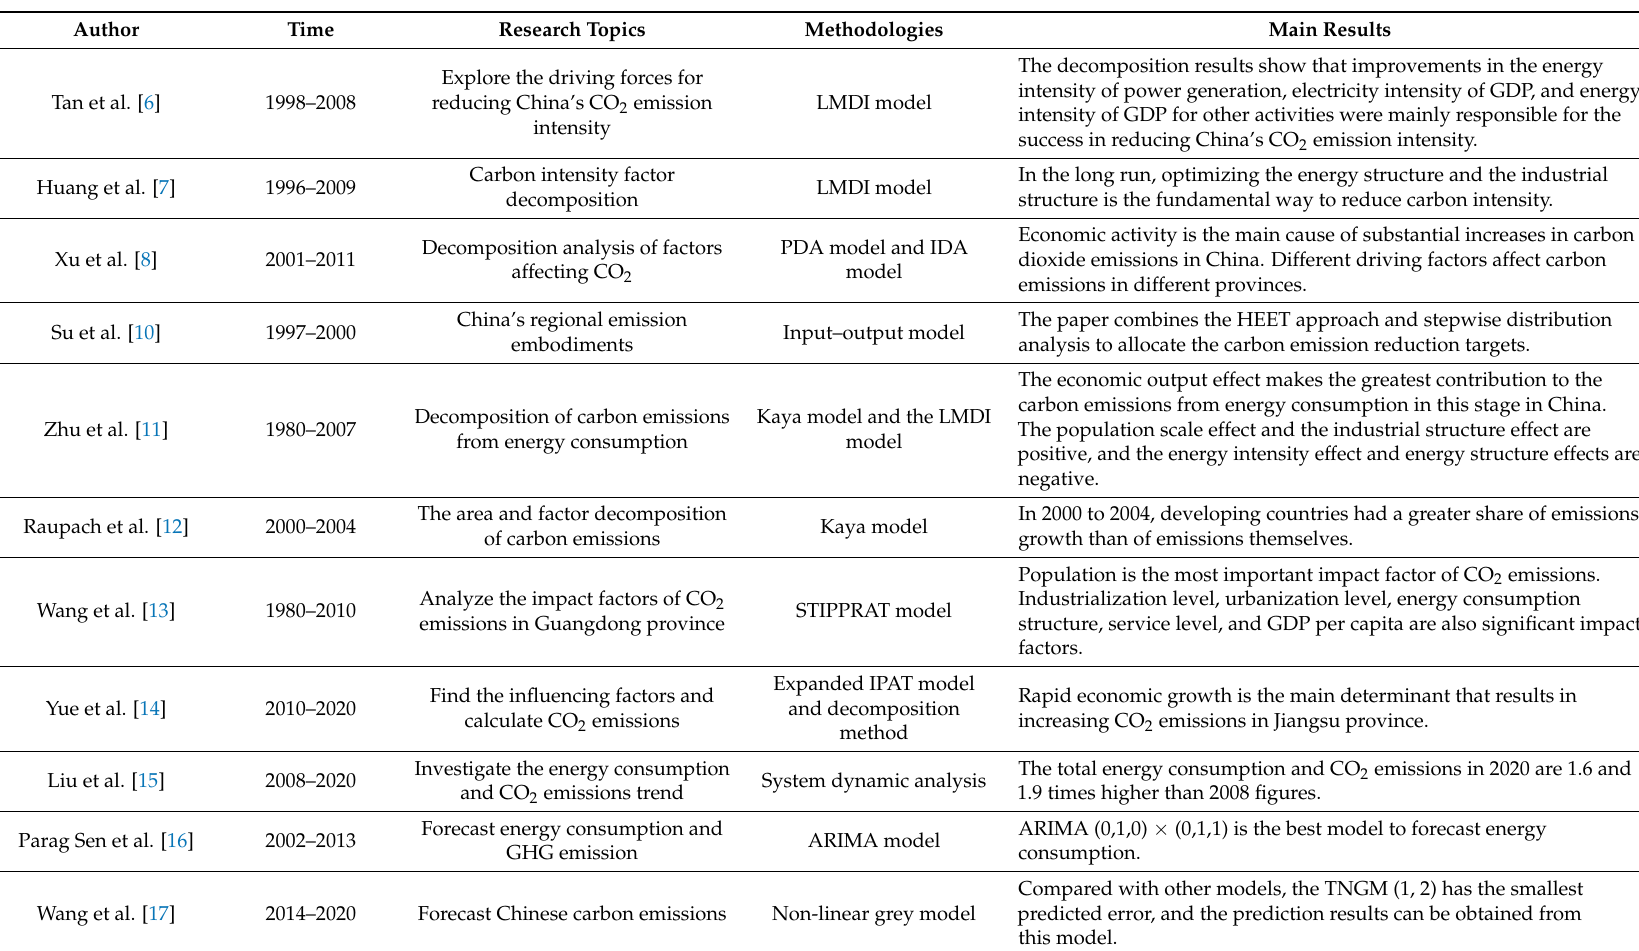
Table A1. Summary of the aforementioned